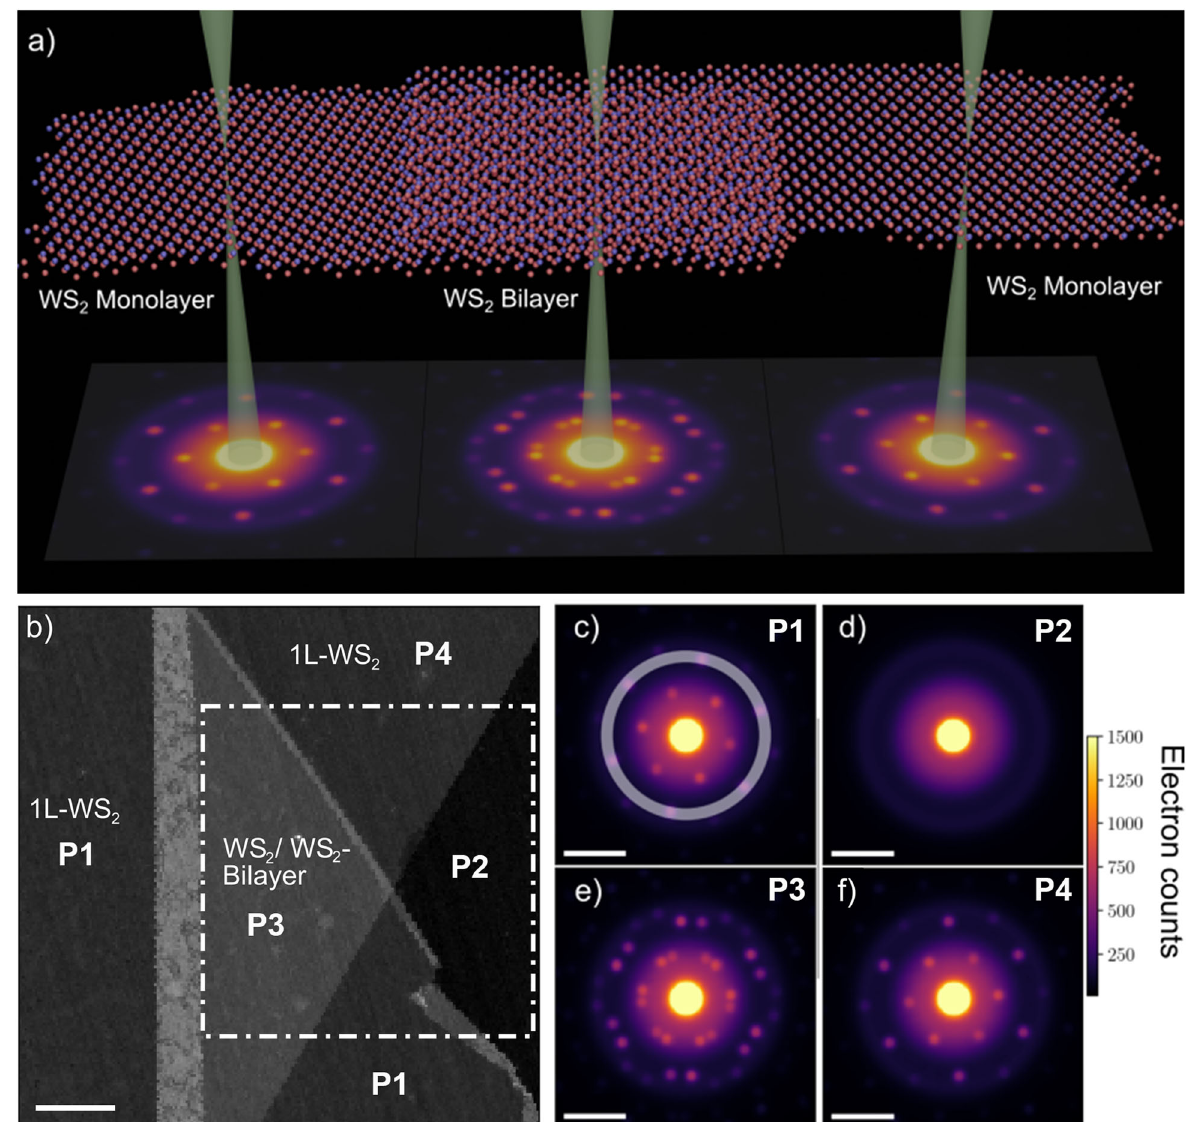
Fig. 5 4D STEM measurements. a Schematic representation of the application of the 4D STEM method for studying WS 2 monolayers. b Virtual dark fi eld image where the intensity in each probe position is summed over selected virtual aperture indicated in ( c ). Scale bar 1 μ m. c – f The mean diffraction from the four regions (P1-4). c The fi rst WS 2 monolayer (P1). d Silicon nitride supporting fi lm (P2). e The bilayer region P3. f The second monolayer P4. Scale bars, 0.5 Å − 1